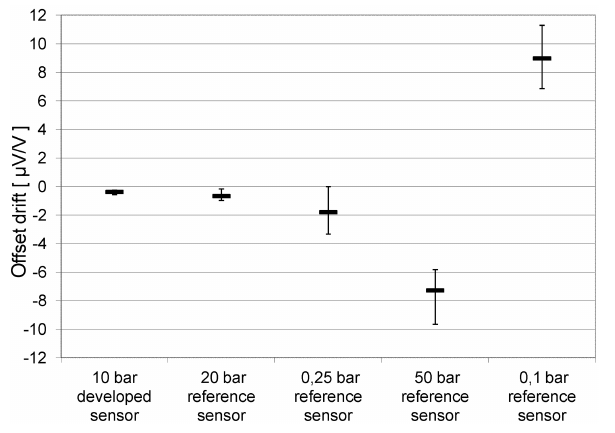
Figure 12. Offset drift over 24h at 135 ◦ C, anodic bonded sensors.